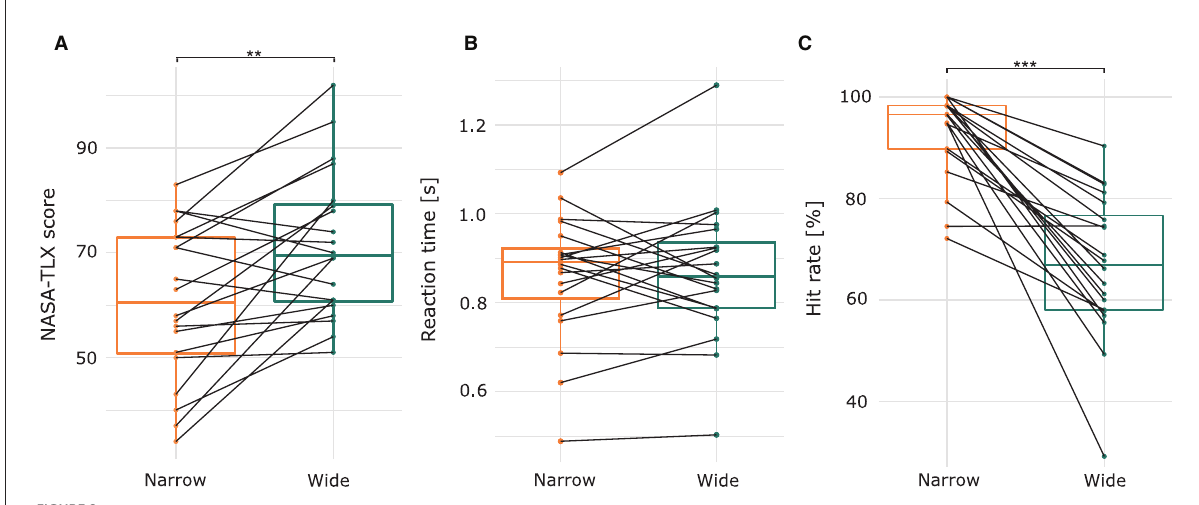
FIGURE2 (A) Subjective workload scores measured by the NASA-TLX. (B) Trial-averaged reaction time and (C ) trial-averaged hit rate in response to the targets of the respective condition, i.e., the alarm and the beep in the narrow and wide condition, respectively. Each black line represents one subject. ** p < 0.01 and *** p <